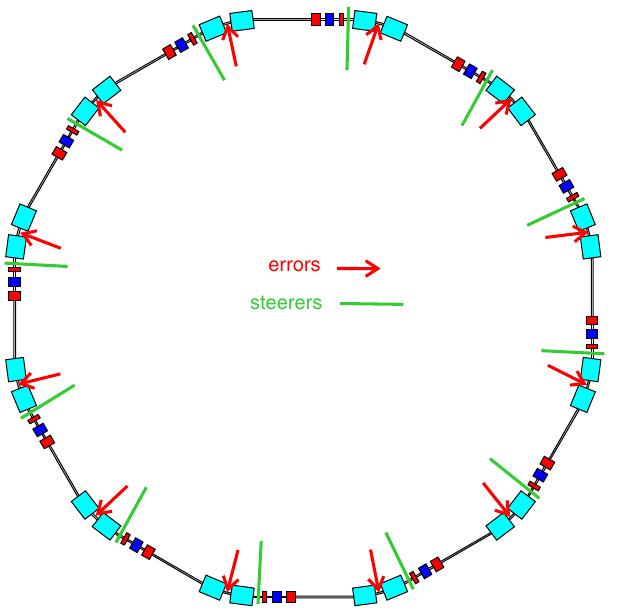
FIG. 2. (Color) SIS18 layout and steerers and nonlinear errors used in the validation simulations.